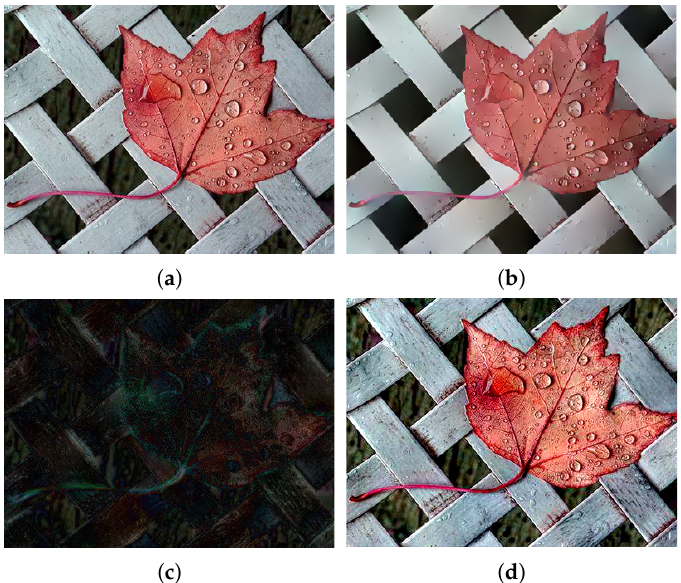
Figure 8. Steps to obtain a details-exaggerated image J . ( a ) Input I ; ( b ) output X from (5) with λ = 25, σ = 0.4; ( c ) | I − X | ; ( d ) details-exaggerated image J = X + 2 ( I − X ) .